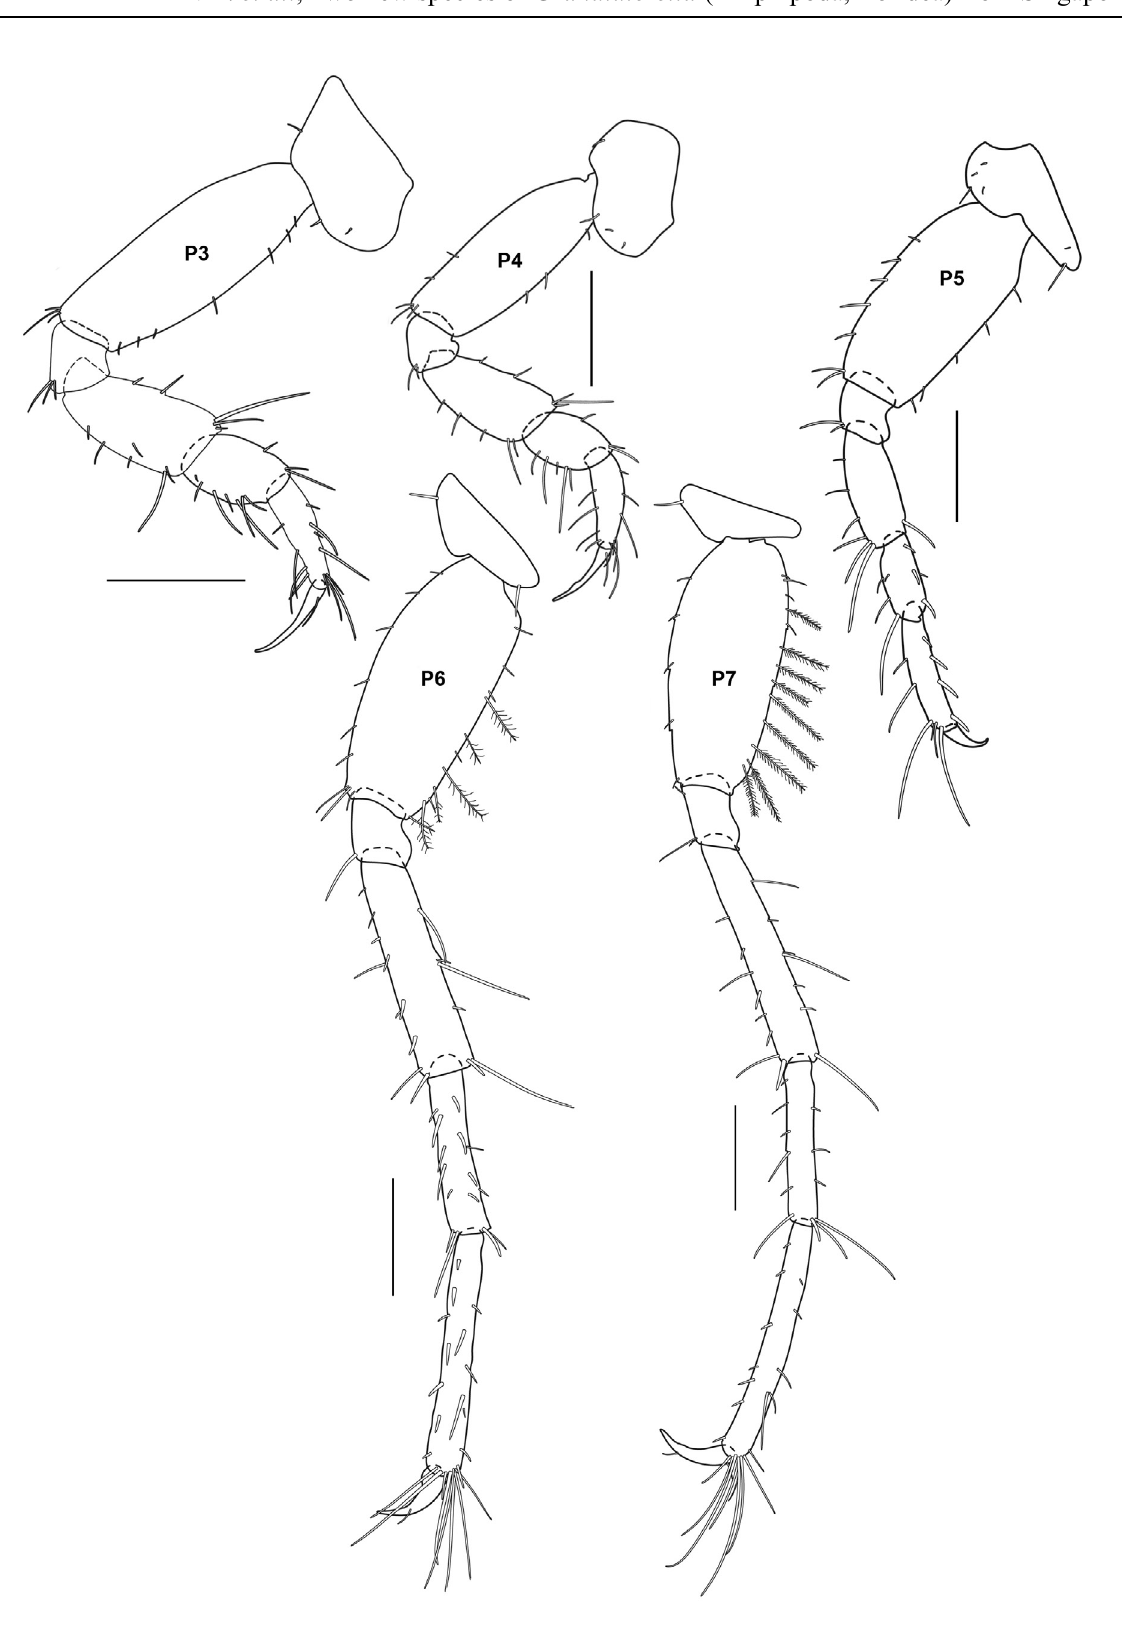
Fig. 9. Grandidierella pawaiensis sp. nov., allotype, ♀ (ZRC 2018.0494). Scale bars: 0.25